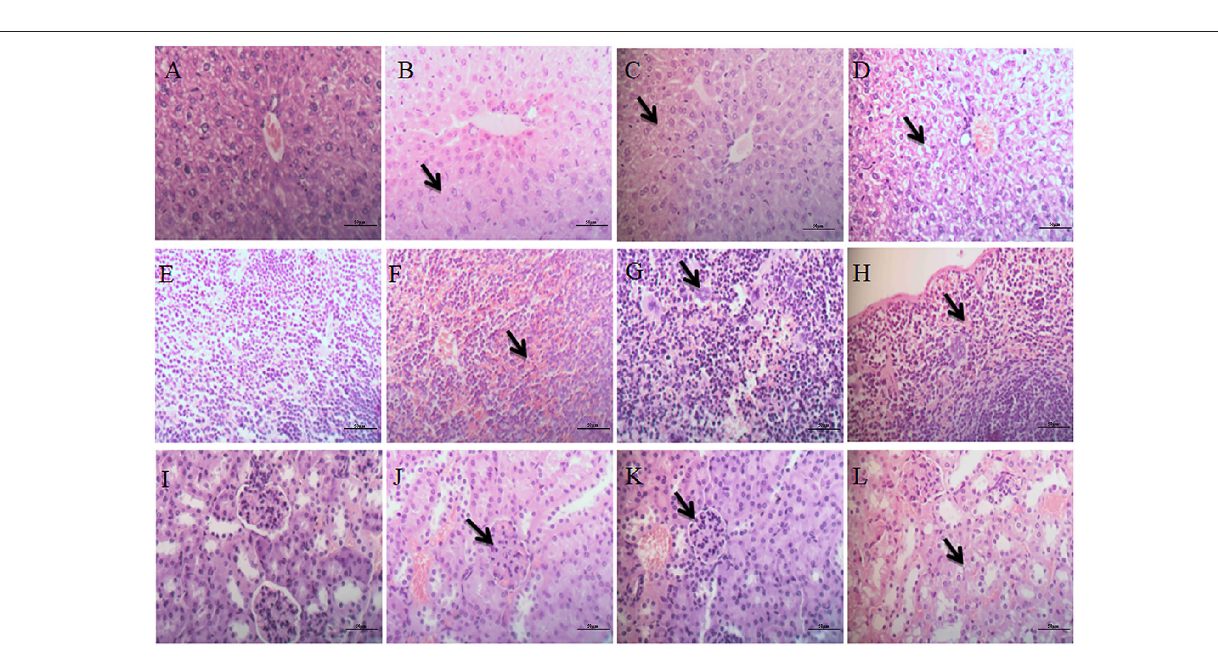
FIGURE 5 | Histopathological examination of liver, spleen and kidneys. (A–D) Represent changes in the liver of control group, low-dose group, middle-dose group, high-dose group ( × 400); (E–H) represent changes in the spleen of control group, low-dose group, middle-dose group, high-dose group ( × 400). (I–L) Represent changes in the kidneys of control group, low-dose group, middle-dose group, high-dose group ( × 400). The black arrow masks the disorganized hepatic cord and cytoplasm vacuolization (B–D) , varying the number of megakaryocytes (F–H) , Interstitial hyperemia and hemorrhage, flocular degeneration of renal tubular epithelial cells (J–L)